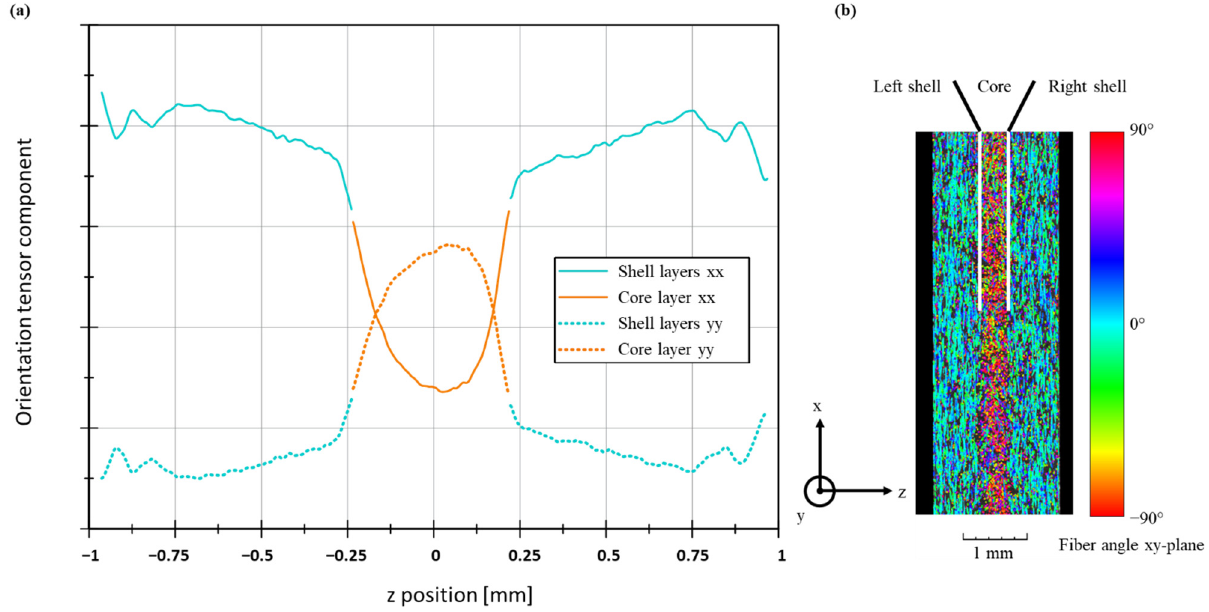
Figure 6. ( a ) Orientation tensor components xx and yy along the specimen’s thickness and ( b ) µCT cross section of the specimen, both with indicated defined frontiers between the core and shell layers.